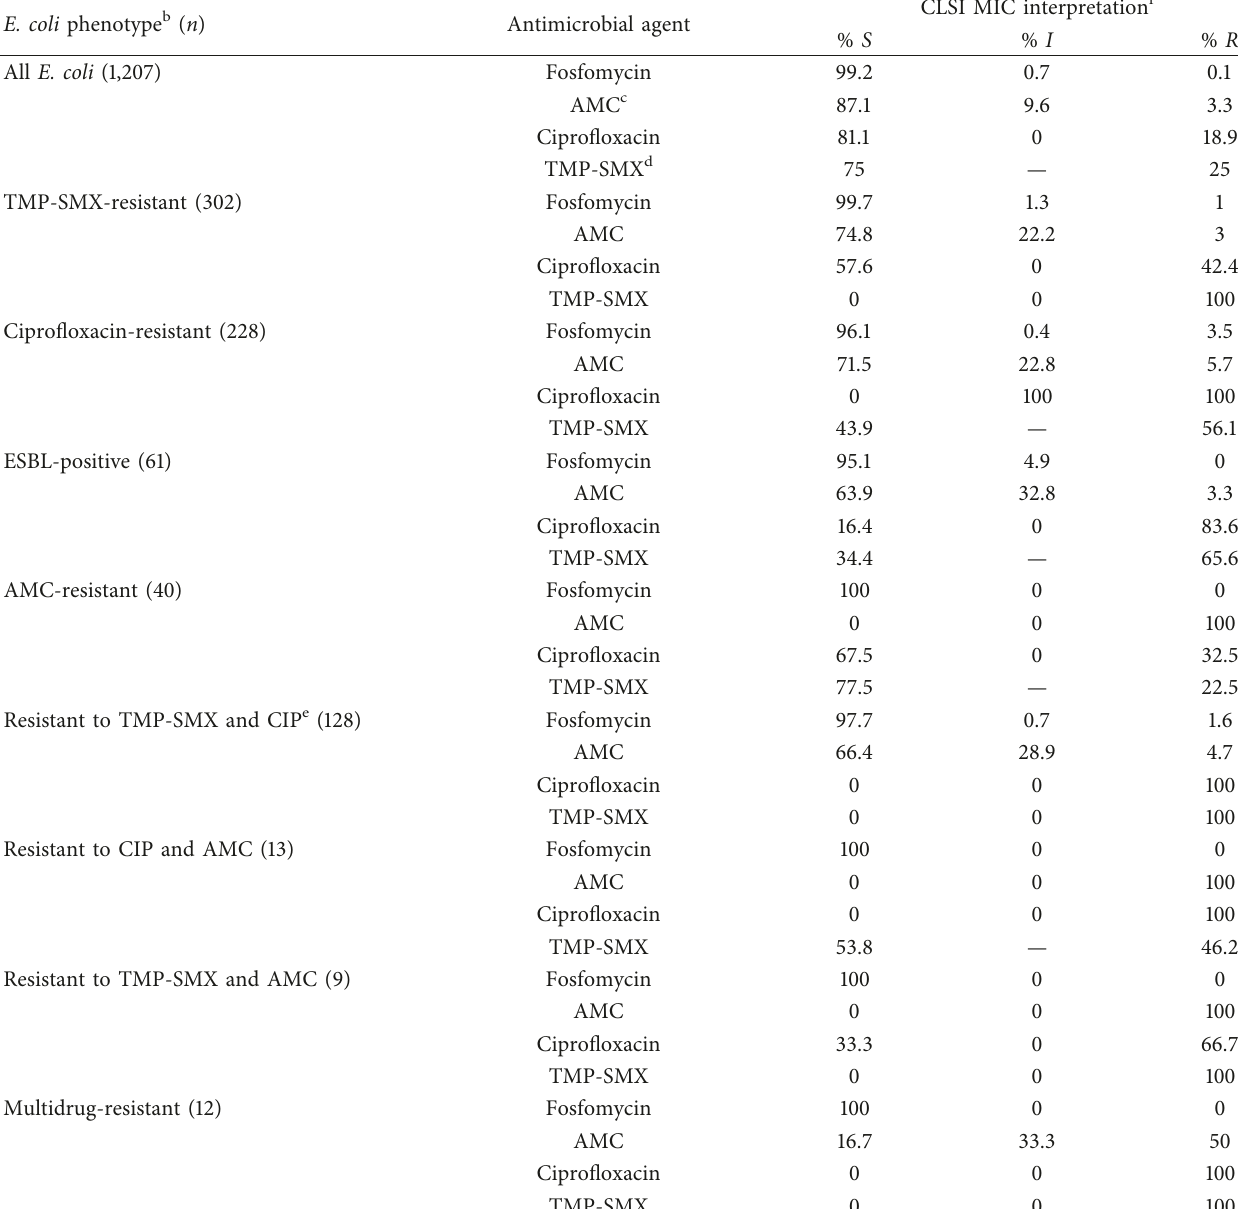
Table 1: In vitro activities of orally prescribed antimicrobial agents against urine isolates of E. coli collected by 15 clinical laboratories across Canada from 2007 to 2015 a